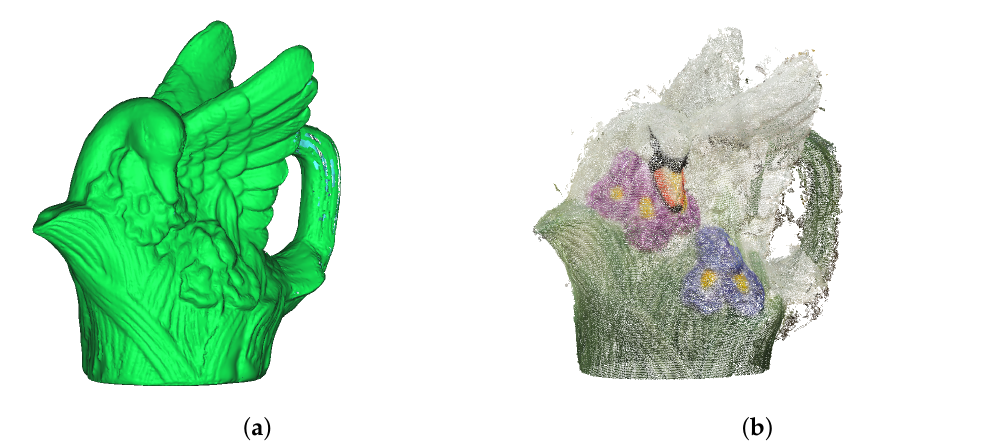
Figure 11. Porcelain figurine models: ( a ) mesh acquired by the 3D scanner, ( b ) point cloud obtained with the use of photogrammetric